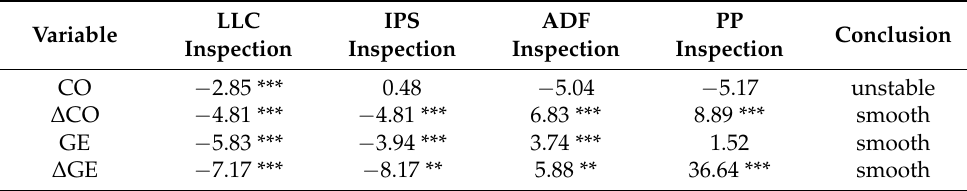
Table 7. Unit root test results.